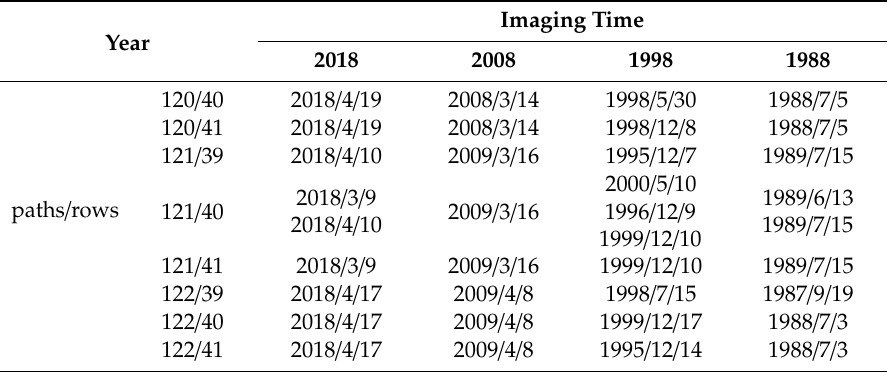
Table 1. Summary of the Landsat images used in this study.